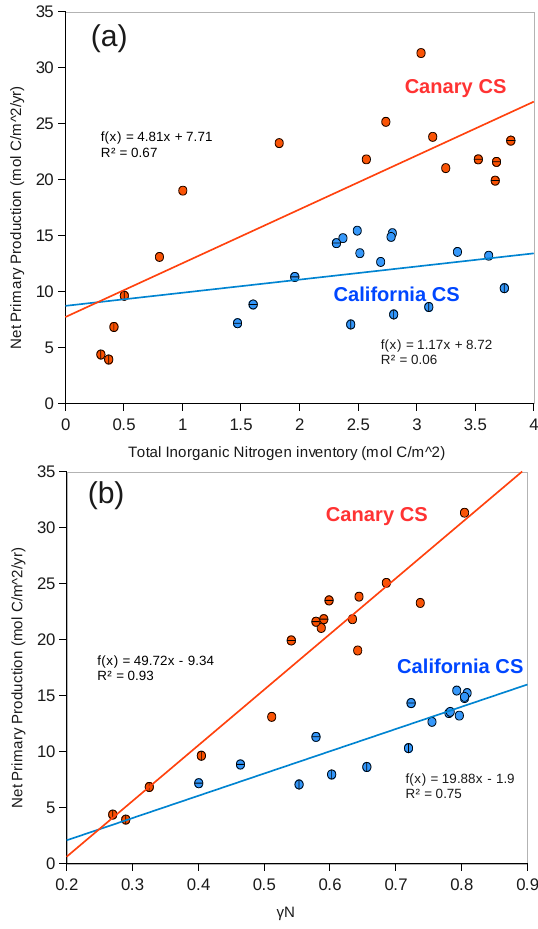
Fig. 5. (a) The relationship between NPP and the inventory of TIN in the euphotic zone in the California CS (blue) and Canary CS (orange). (b) NPP as a function of the nutrient limitation factor γ(N n ,N r ) averaged over the upper 40m in the California CS (blue) and Canary CS (orange). Data were averaged over the 300km wide nearshore area and over 1 ◦ bins in meridional direction. Circles with horizontal lines correspond to the southernmost part of each system, i.e., from 30 ◦ N to 34 ◦ N for the California CS and from 12 ◦ N to 16 ◦ N for the Canary CS, and circles with vertical lines indicate their northernmost parts, i.e., from 42 ◦ N to 46 ◦ N for the California CS and from 24 ◦ N to 28 ◦ N for the Canary